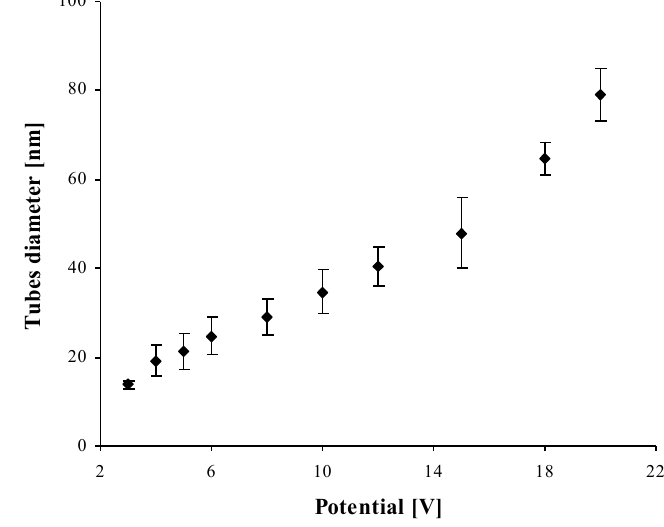
Figure 9. The diameter of titania nanotubes as a function of used potential.